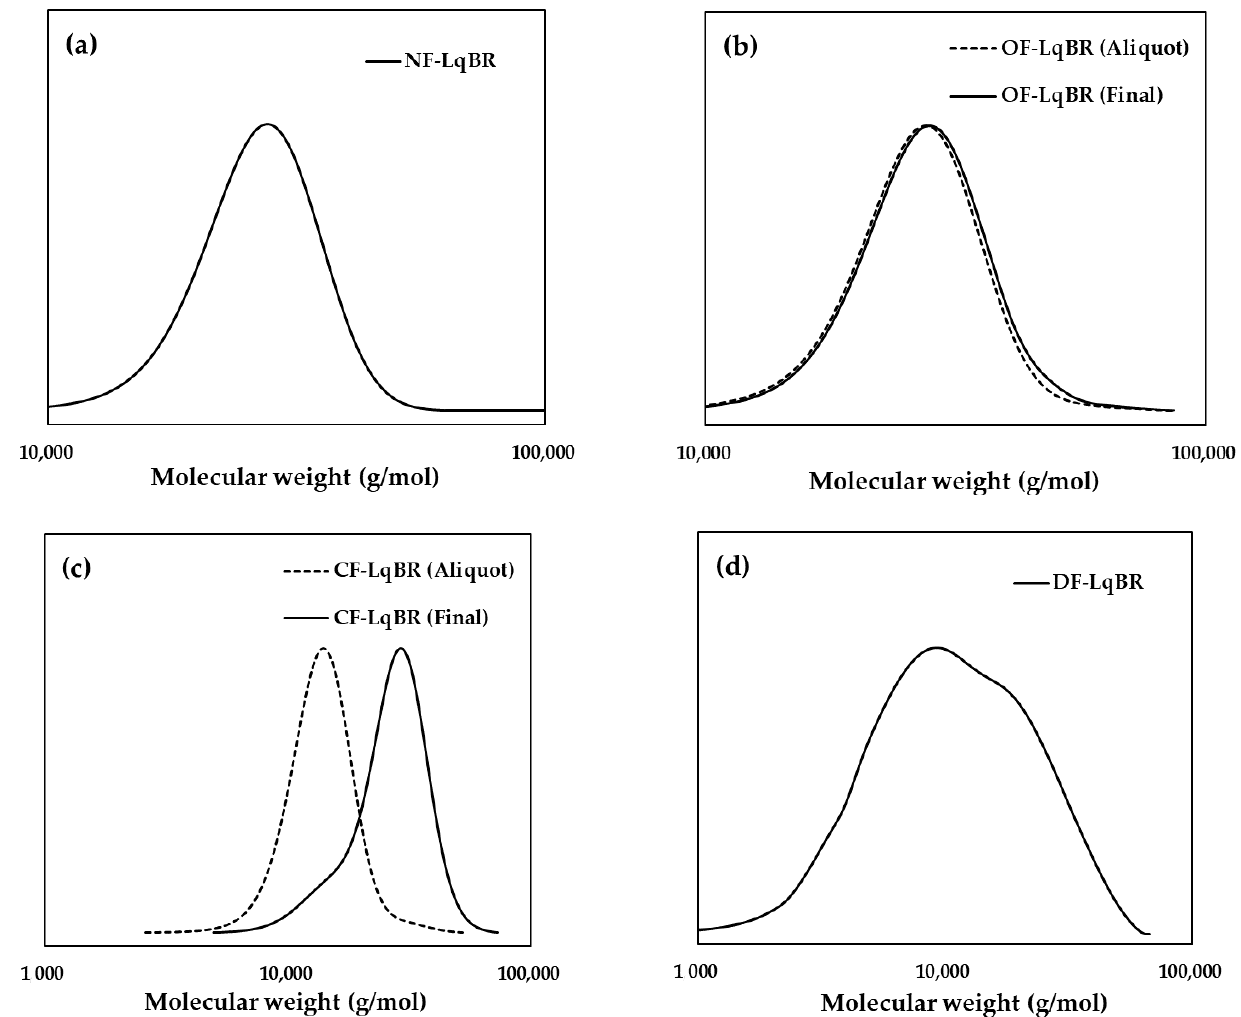
Figure 2. Gel permeation chromatography (GPC); ( a ) NF-LqBR, ( b ) OF-LqBR, ( c ) CF-LqBR, and ( d ) DF-LqBR.